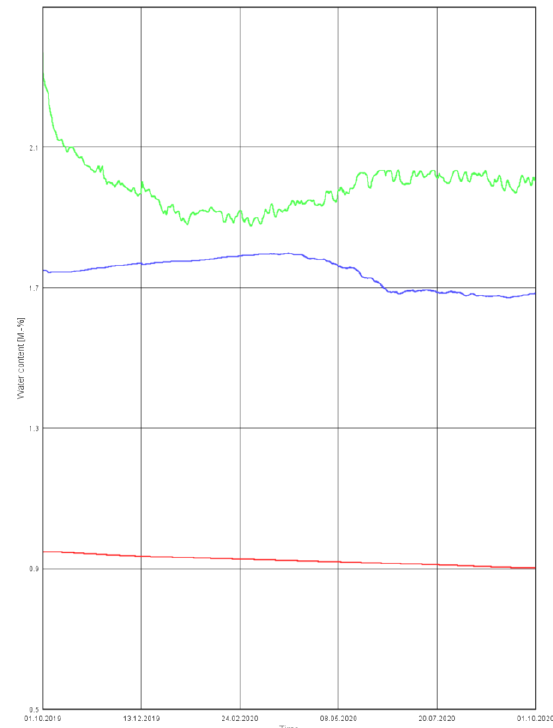
Energies 2020 , 13 , x FOR PEER REVIEW Figure 28. Water content changes for the entire calculation model. Figure 28. Water content changes for the entire calculation model.